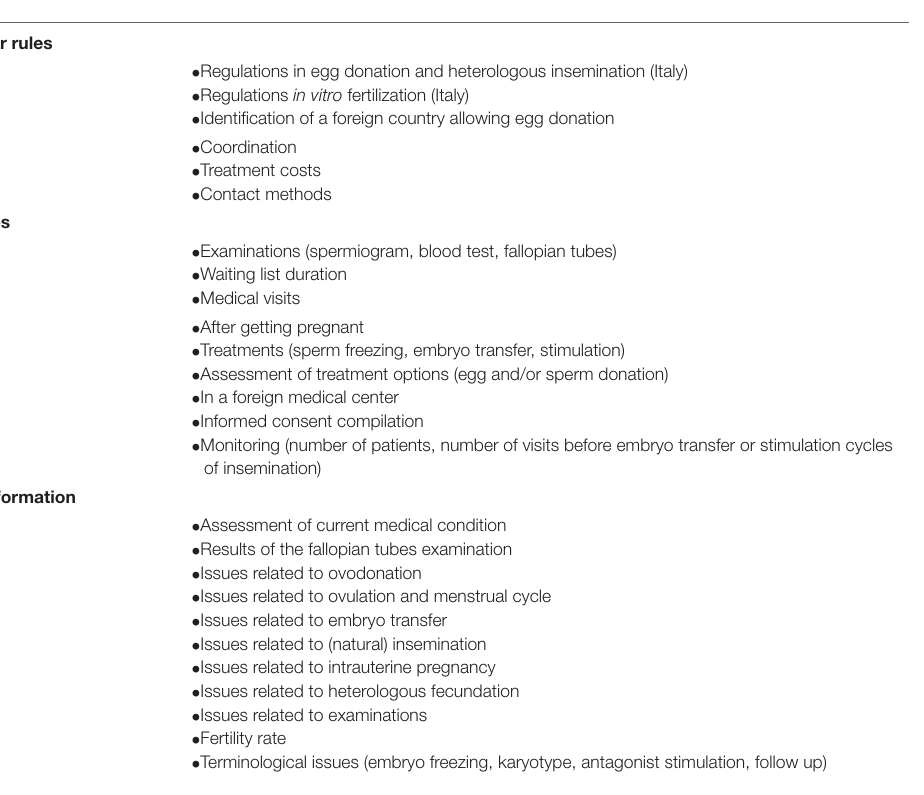
TABLE A1 | Topics and subtopics used to classify strong types of misunderstandings. Topics and